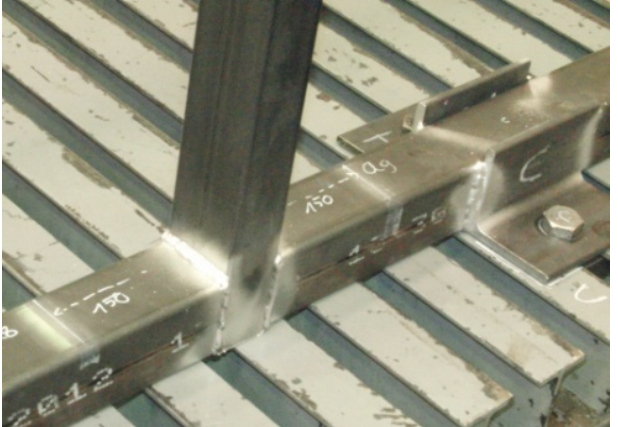
Figure 5. Clamping weld details.